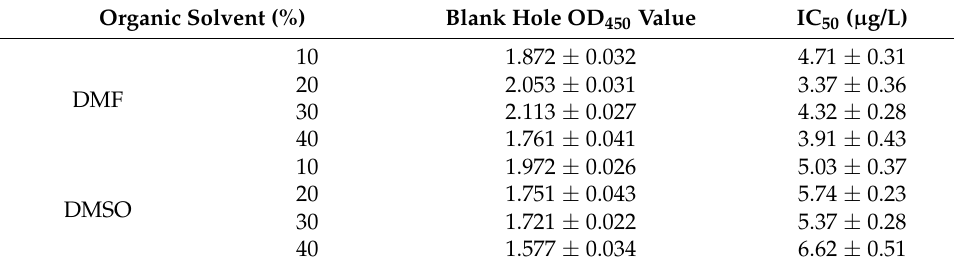
Table 1. Comparison of different DMF and DMSO contents.